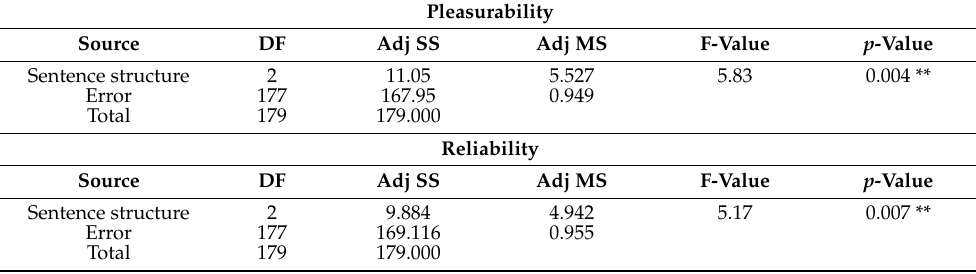
Table A4. One-way ANOVA for “Sentence structure of the answer”. **: p -value < 0.05.